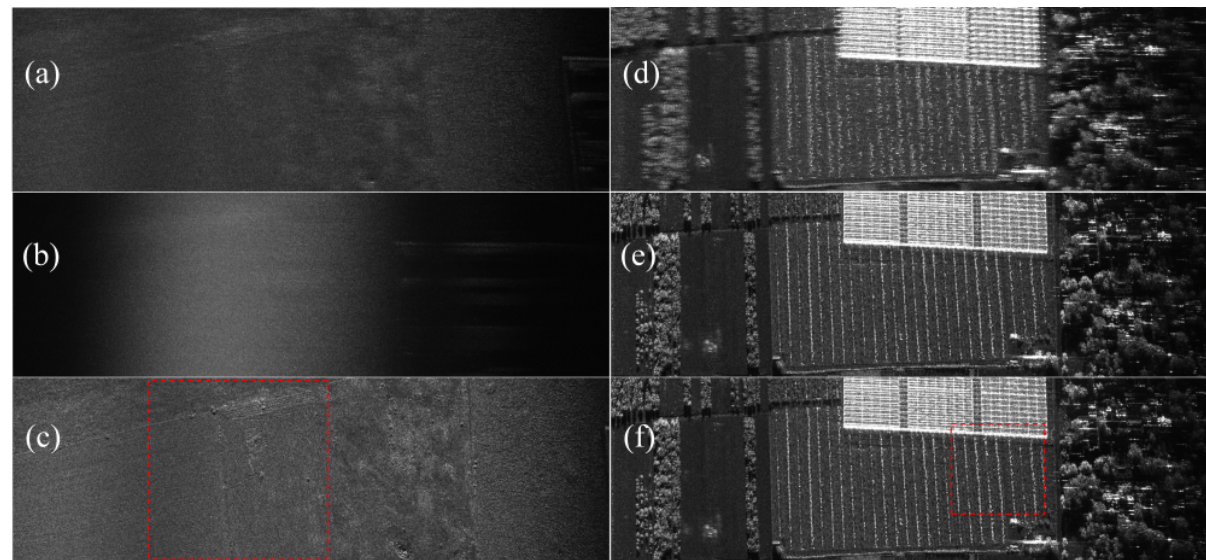
Figure 6. Autofocus imageries of imageries 5 (cid:13) and 6 (cid:13) . No autofocus ( a , d ), PGA autofocus ( b , e ), the proposed approach ( c , f ).